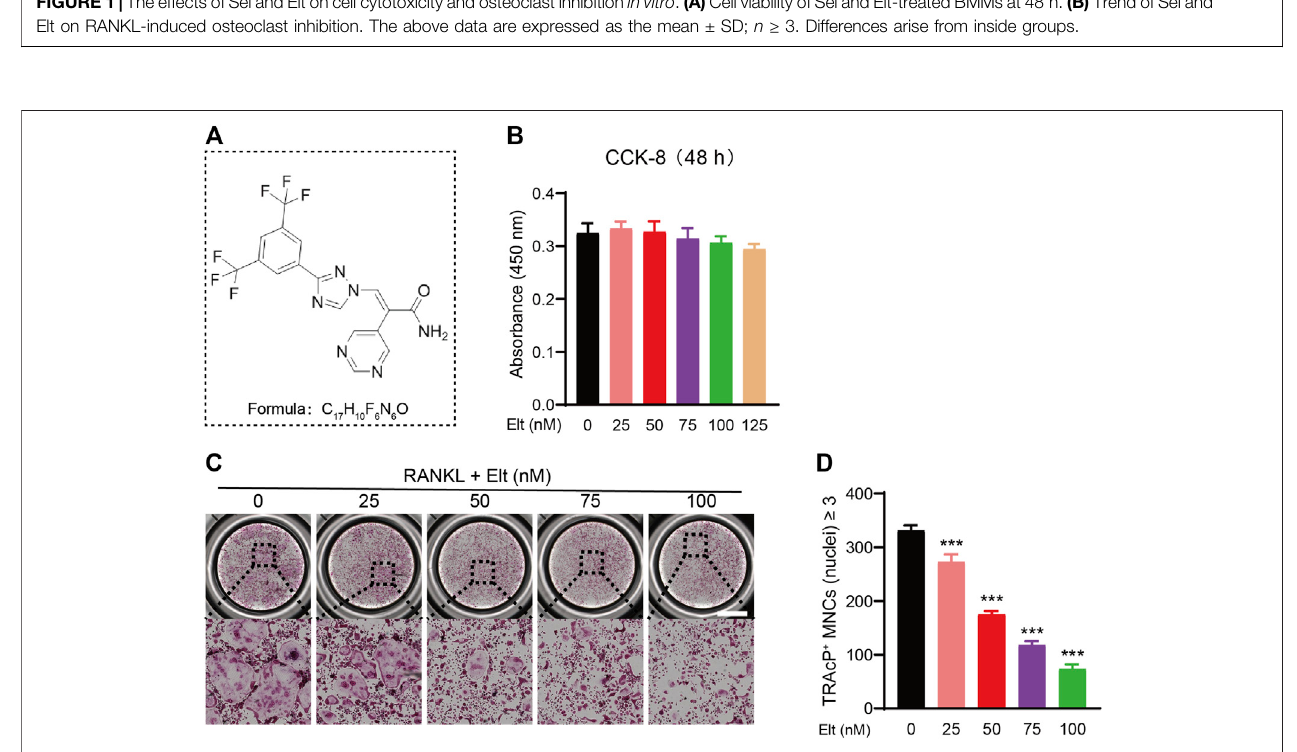
FIGURE2| EltinhibitsRANKL-inducedosteoclastformation invitro . (A) ThechemicalstructureandformulaofandElt. (B) CellviabilityofElt-treatedBMMsat48 h. (C) BMMs were stimulated with RANKL for 5 days, and representative images of TRAcP staining showed that Elt inhibited osteoclast formation in a dose-dependent manner (scale = 1,000 μ M). (D) Quanti fi cation of the number of TRAcP + multinucleated cells (nuclei ≥ 3). The above data are expressed as the mean ± SD; n ≥ 3; *p < 0.05 compared to control group.